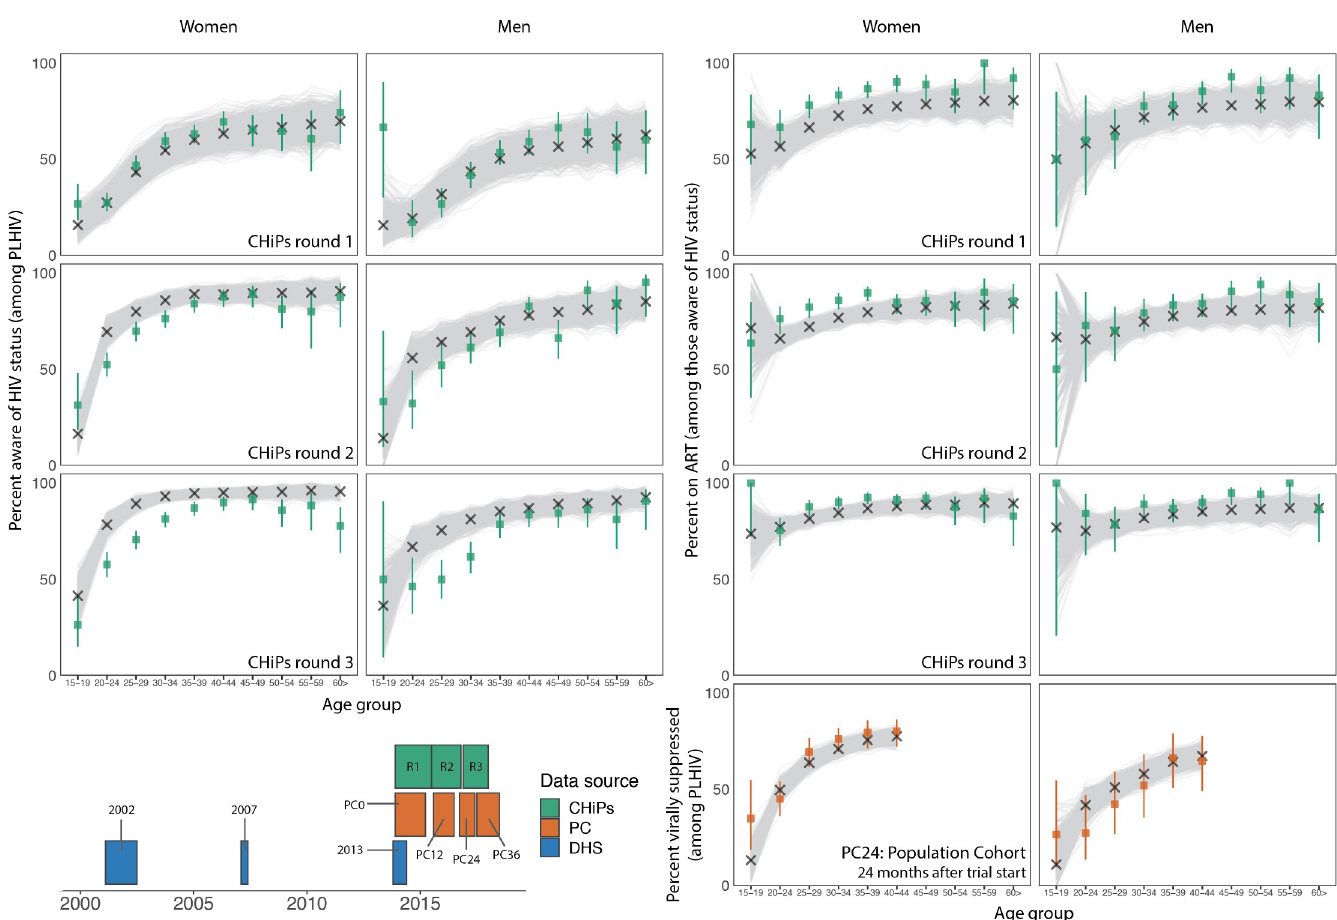
Fig 5. Calibration of PopART-IBM to PC and CHiPs datasets for women (columns 1 and 3) and men (columns 2 and 4). For all graphs, the x-axis shows 5 year age groups, starting at 15–19 years. Panel shows percentage of PLHIV who are aware of status from CHiPs rounds 1–3 (columns 1–2), percentage of PLHIV aware of status who are on ART (top 3 rows, columns 3–4); viral suppression amongst all PLHIV from PC24 (bottom row, columns 3–4); and a Gantt chart showing the times that different data sources were collected (bottom left). In each graph the coloured bars represent the data used for calibration (observed proportions in each subgroup, with 95% confidence intervals), with corresponding colour in the Gantt chart; the grey lines represent the outputs from the 1,000 calibrated model runs; and the crosses represent the best model fit output.